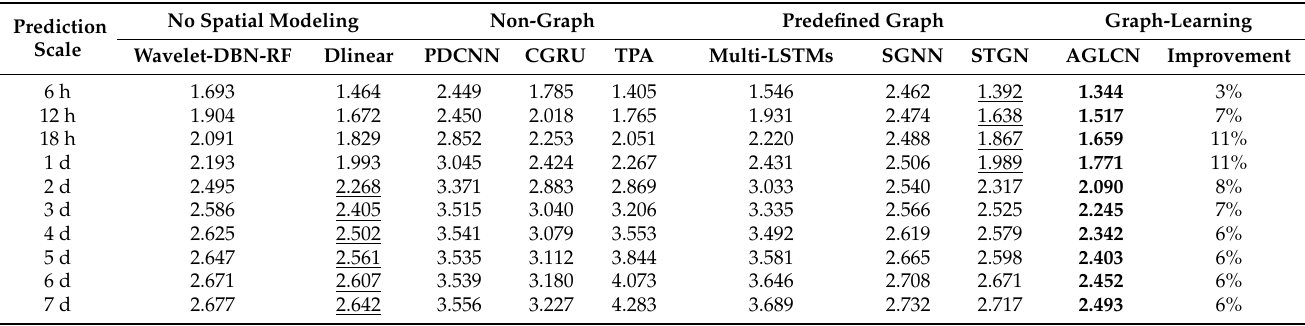
Table 2. RMSE of forecasting methods for 40 nodes.